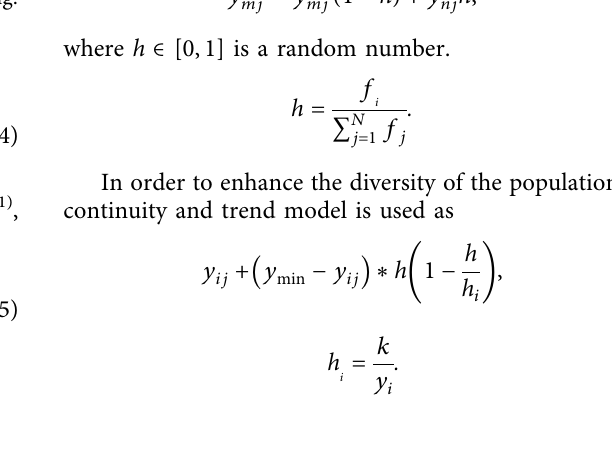
Figure 3: The hardware architecture of multimachine